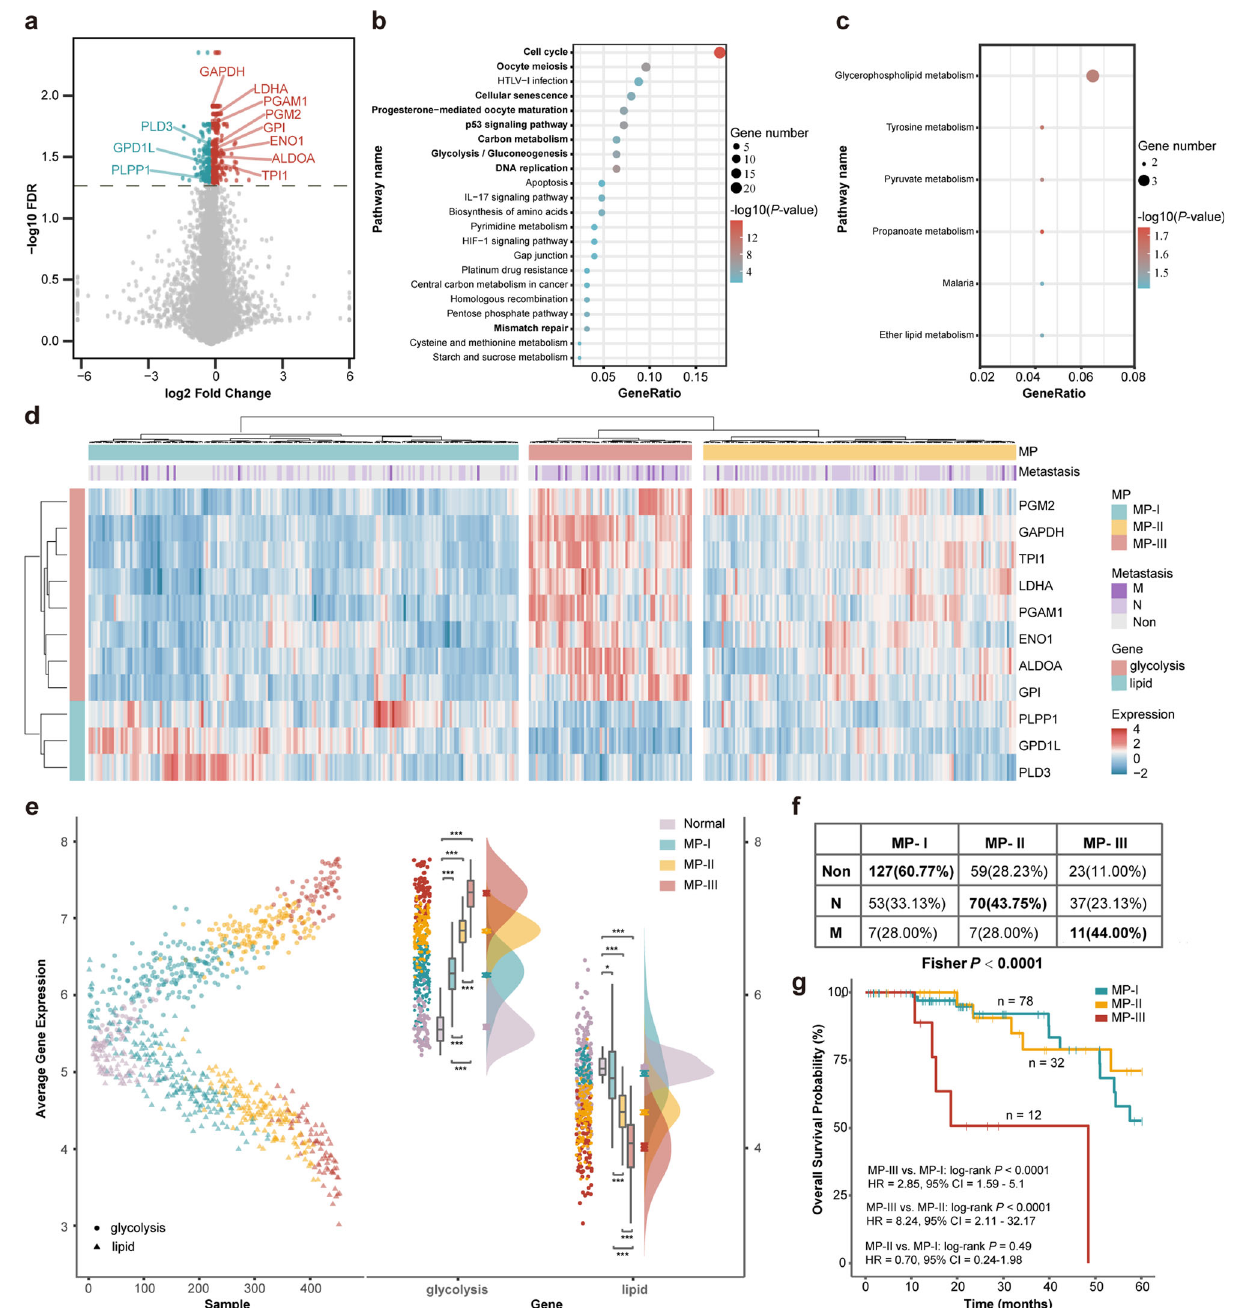
Fig. 1 Identi fi cation of metabolic reprogramming phenotypes (MPs) in the TCGA dataset. a Volcano plot of differentially expressed (DE) genes between metastatic and non-metastatic samples. Red and blue represented upregulated and downregulated DE genes, respectively. b , c Functional pathways enriched with upregulated ( b ) and downregulated ( c ) DE genes. d Hierarchical clustering heatmap for all the samples based on the mRNA expression ( Z - score) of the 11 DE metabolic genes ( n = 394 biologically independent samples). Here, the samples were clustered into the three MPs; the one with lower expression of glycolytic genes accompany by higher lipid metabolic genes were de fi ned as MP-I, the one with higher expression of glycolytic genes accompanied with lower lipid metabolic genes was de fi ned as MP-III, and the other one showing intermediate mRNA expression of all metabolic genes was de fi ned as MP-II. e Average expression of glycolytic and lipid metabolic genes across the three MPs and normal samples. Boxplots extend from the 25th to 75th percentiles, the line indicates the median, and whiskers indicate the range. f Confusion matrix for the number of metastatic samples in the different MPs. g Kaplan – Meier curves of overall survival for 122 samples obtained from treatment-naive patients with stage I (Fig. 5h). A similar metabolic trajectory was observed from normal to mBrain (Supplementary Fig. 3).